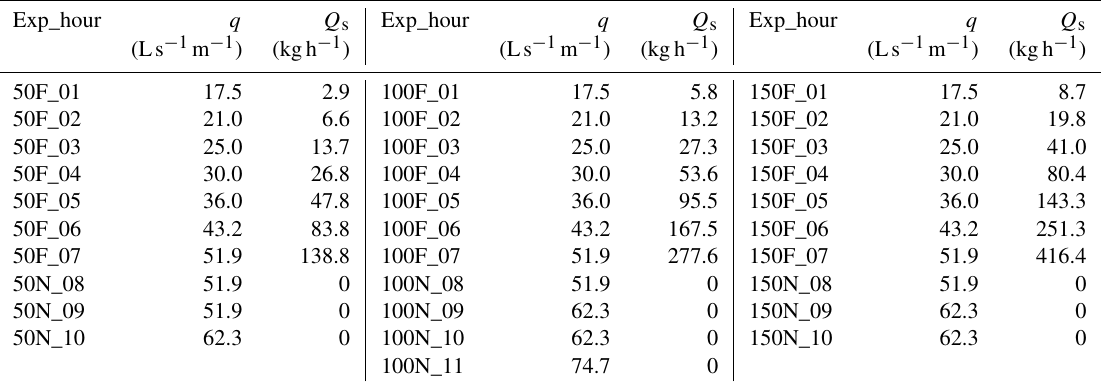
Figure 2. (a) Top view of the flume geometry used in the experiments. Grains of different sizes were painted in different colors to facilitate grain-size recognition and surface structure detection. (b) Channel segments of longitudinal width variations. The flow is from right to left. Table 1. Values of unit discharge q and sediment feed rate Q s used in the